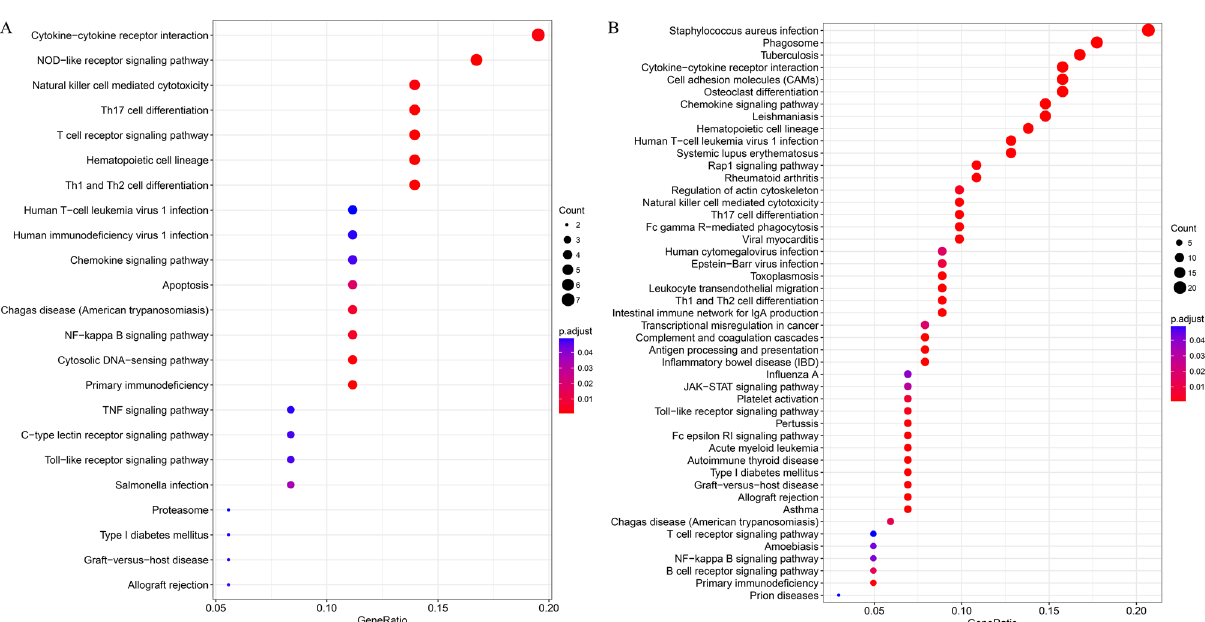
Figure 5. Immune score-related gene modules identified via WGCNA. ( A ) Cluster analysis of samples. ( B , C ) Network topological analysis for different soft-thresholding powers. ( D ) Module colors and gene dendrogram. ( E ) Correlations between different gene modules and 3 ESTIMATE Scores. The intensity of red and green colors indicates the value of correlation coefficient.